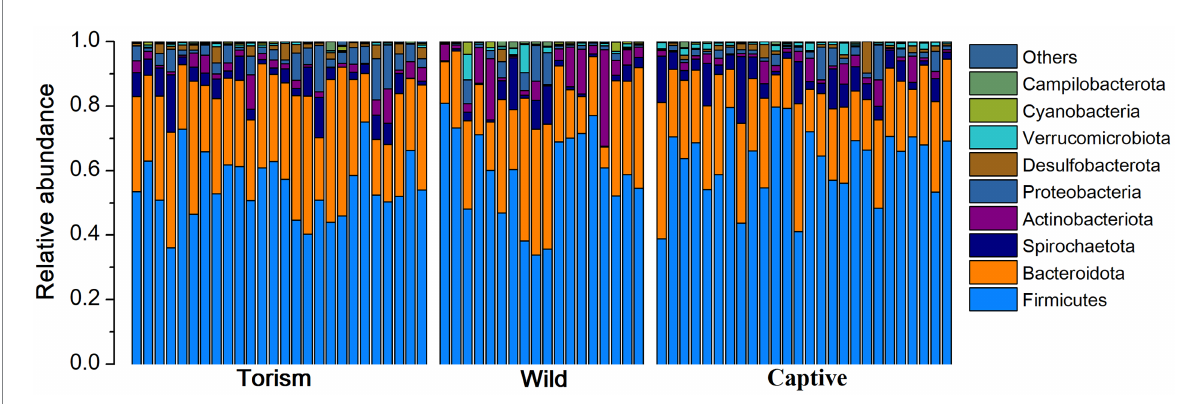
FIGURE 1 Relative abundance of fecal bacterial taxa at the phylum level. Stacked bar graphs illustrate the abundances of phyla and the x-axis represents the sample groups.